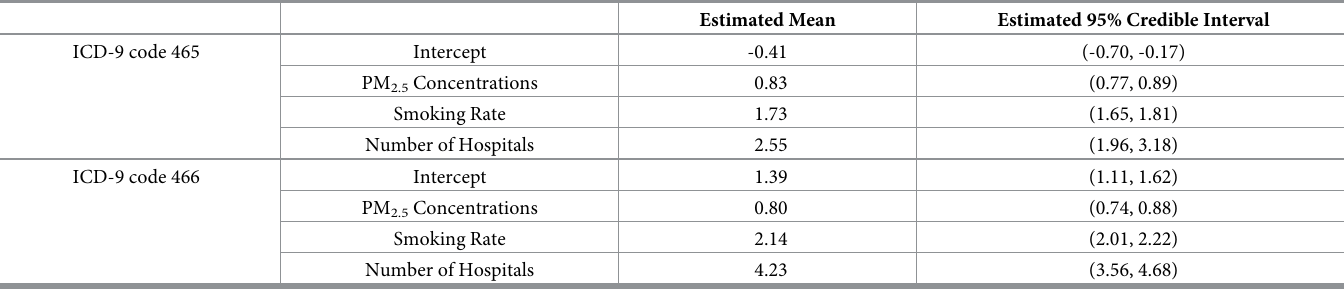
Table 5. Estimation results of the CG model for acute upper respiratory infections of multiple or unspecified site (ICD-9 code 465) and acute bronchitis and bronchiol- itis (ICD-9 code 466). The estimated mean and 95% credible intervals for different variables are